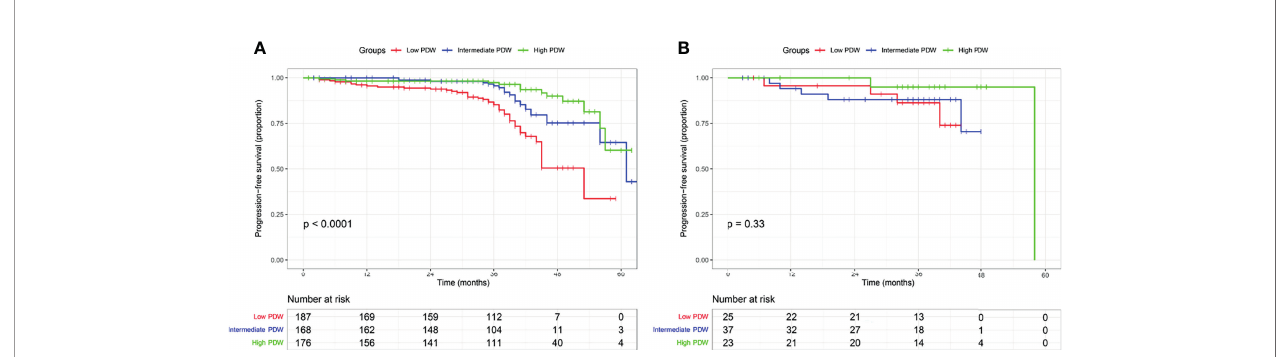
FIGURE 2 | Kaplan – Meier curve of progression free survival in clear cell renal cell carcinoma (A) and non-clear cell renal cell carcinoma (B) strati fi ed according to platelet distribution width.